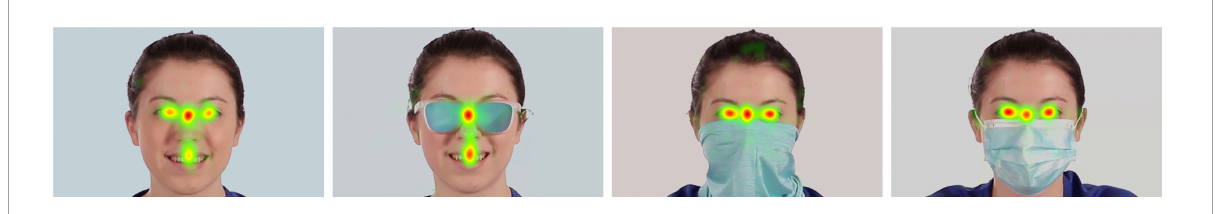
FIGURE2 Example of heat maps for the exploration of a happy face. The mean time spent for all participants is represented by a color gradient from green (low time spent) to red (high time